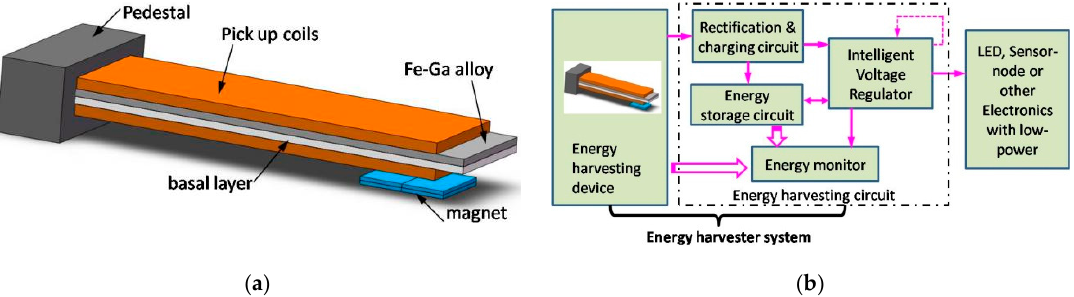
Figure 1. Structure of the proposed Fe-Ga-based cantilever vibration harvester: ( a ) harvesting device; ( b ) energy harvesting and storage circuit.